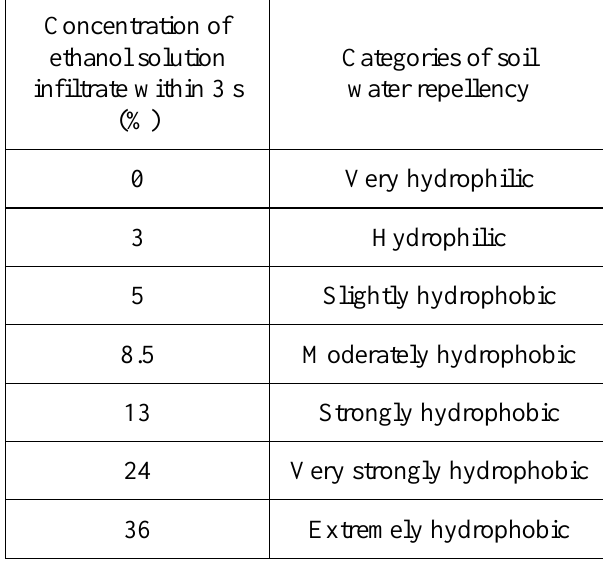
Table 2. Soil water repellency (Doerr